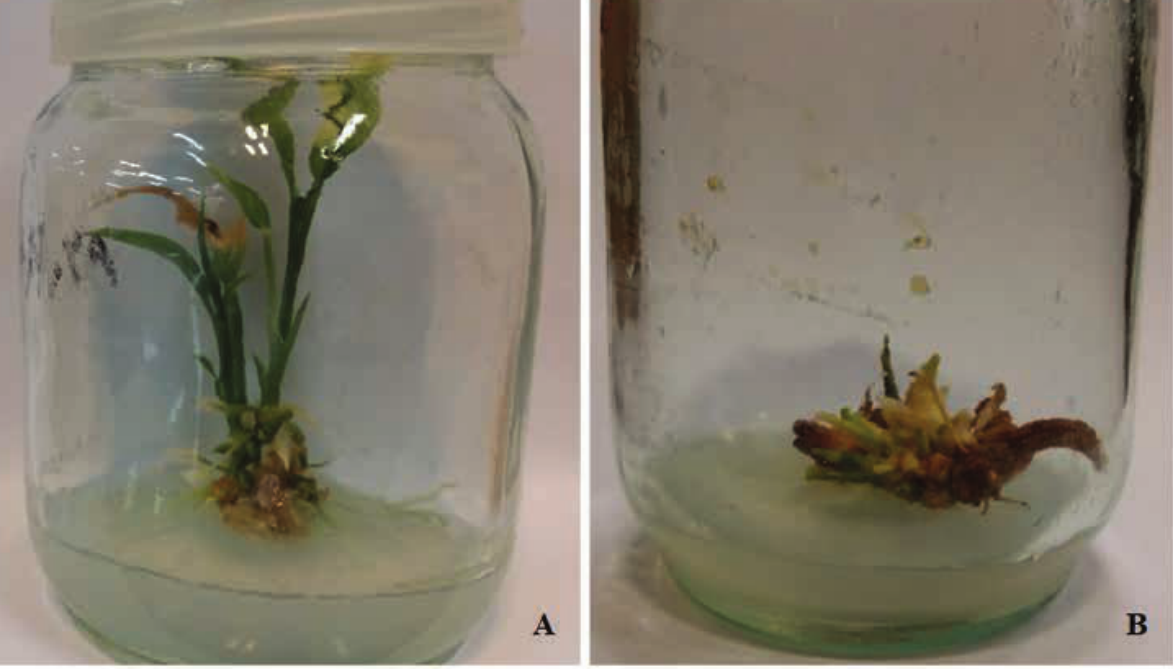
Figure 1: In vitro shoot multiplication of ginger four weeks after cultivation on MS medium supplemented with 1 mg/l Kin (A) and 10 mg/l BA